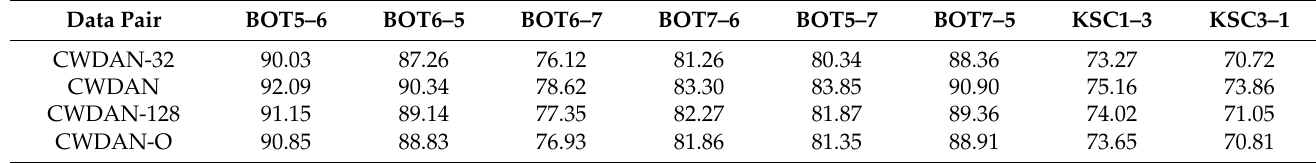
Table 5. Classification performance (OA, %) with different numbers of